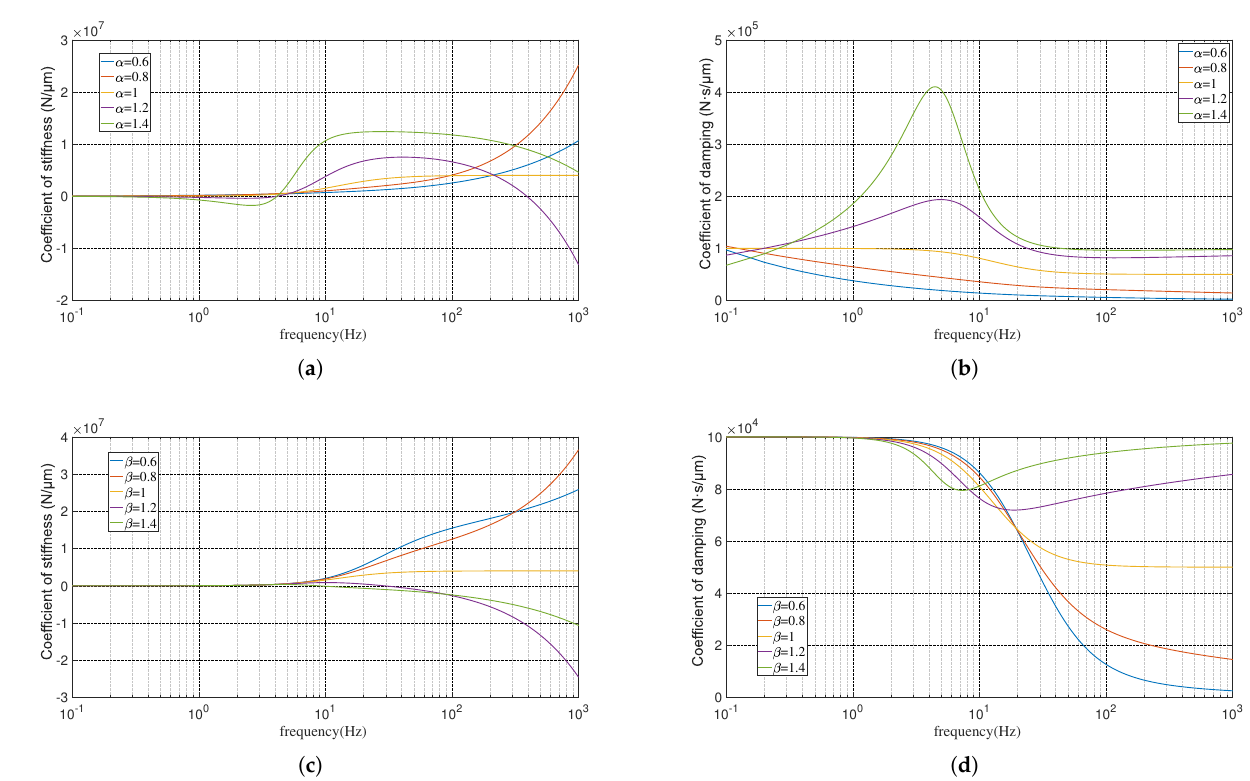
Figure 11. Effect of the fractional order on the dynamic characteristics of the FOTGF model. ( a ) Change of dynamic stiffness with the α order. ( b ) Change of damping with the α order. ( c ) Change of dynamic stiffness with the β order. ( d ) Change of damping with the β order.